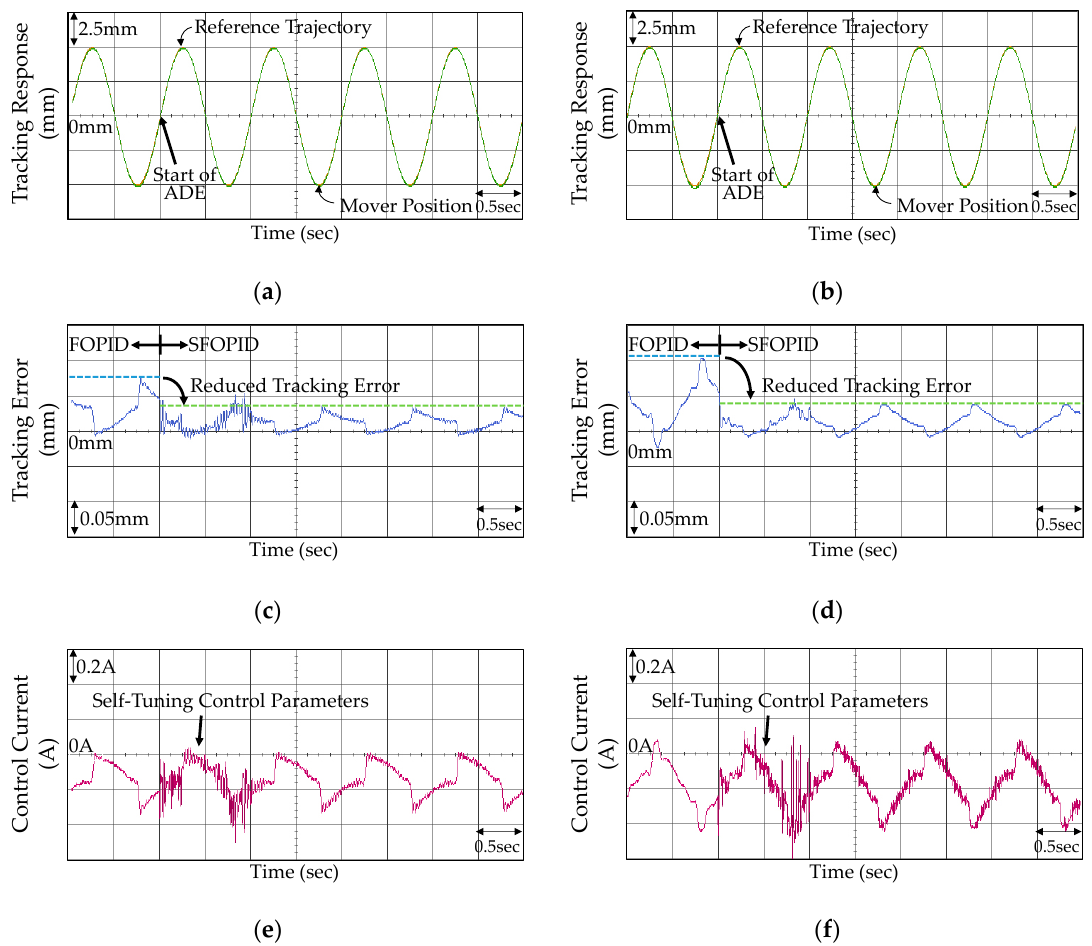
Figure 10. Experimental results of the VCM control system using the SFOPID controller: ( a ) tracking response in Case 1; ( b ) tracking response in Case 2; ( c ) tracking error in Case 1; ( d ) tracking error in Case 2; ( e ) control current in Case 1; and ( f ) control current in Case 2.